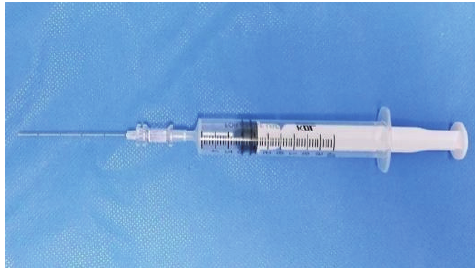
Figure 2 10-mL syringe used as the auxiliary instrument for negative pressure aspiration of thyroid nodules